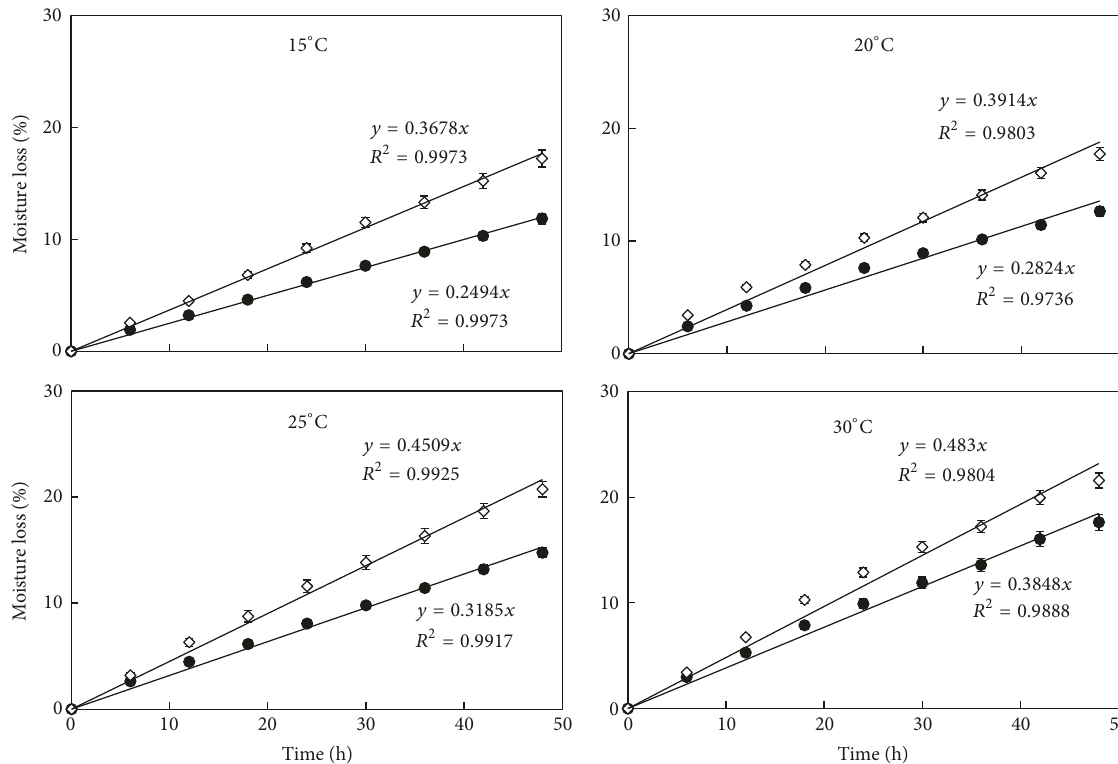
Figure 1: Moisture loss of control ( ⬦ ) and wax treated ( e ) cucumbers stored at different temperatures, but all with 55% relative humidity. The lines (—) represent model estimates from